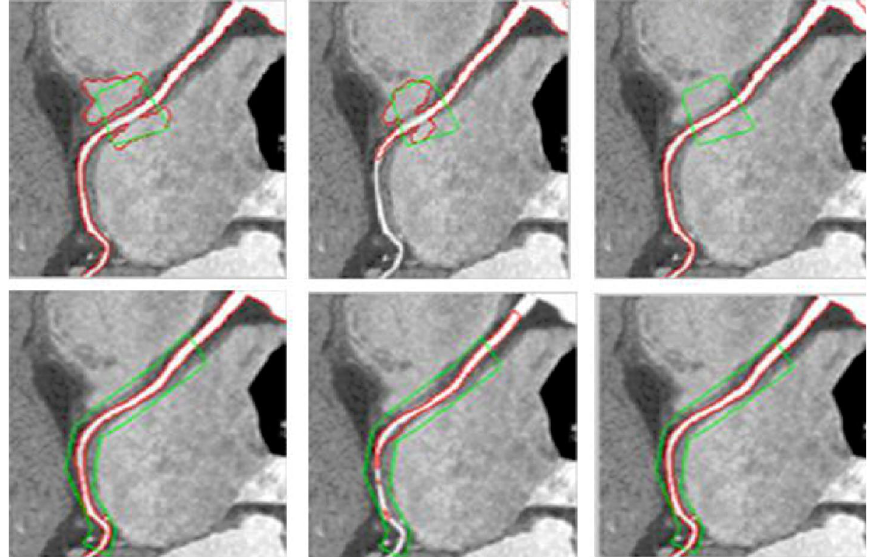
FIG. 6. SEGMENTATION EFFICIENCY OF THREE METHODS AGAINST TWO DIFFERENT INITIALIZATIONS ON CLINICAL CPR IMAGE (LEFT) LOCALIZATION METHOD (MIDDLE) YIN’S METHOD (RIGHT) PROPOSED METHOD, GREEN IS INITIALIZATION AND RED IS FINAL SEGMENTATION